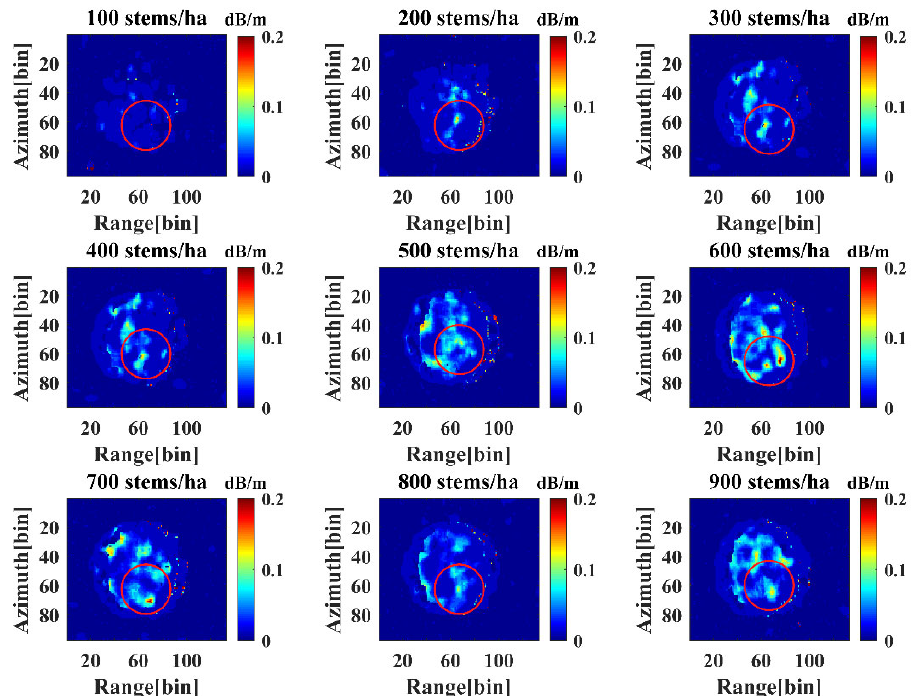
Figure 14. The two-dimensional maps depict the extinction coefficients of nine groups of stands Figure 14. The two ‐ dimensional maps depict the extinction coefficients of nine groups of stands inverted using the traditional three-stage inversion method, with red circles representing the same inverted using the traditional three ‐ stage inversion method, with red circles representing the same locations of the nine groups of forest locations of the nine groups of forest stands.